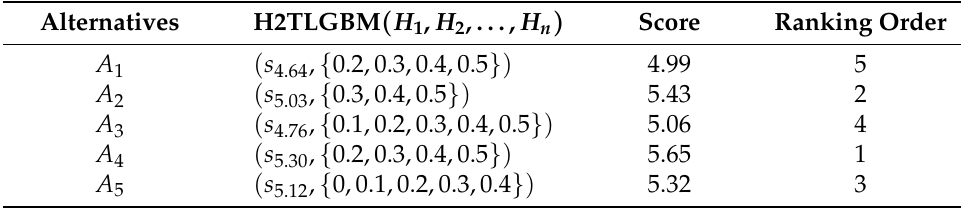
Table 9. Ranking of alternatives by using H2TLGBM operator when p = 2, q = 1.